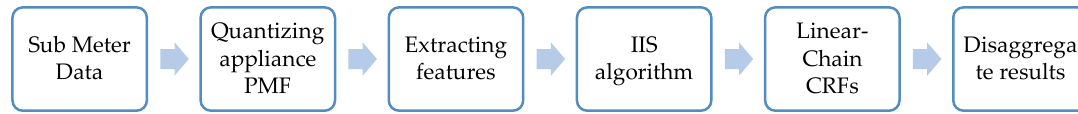
Figure 2. Main framework of our linear-chain CRF model for NILM.